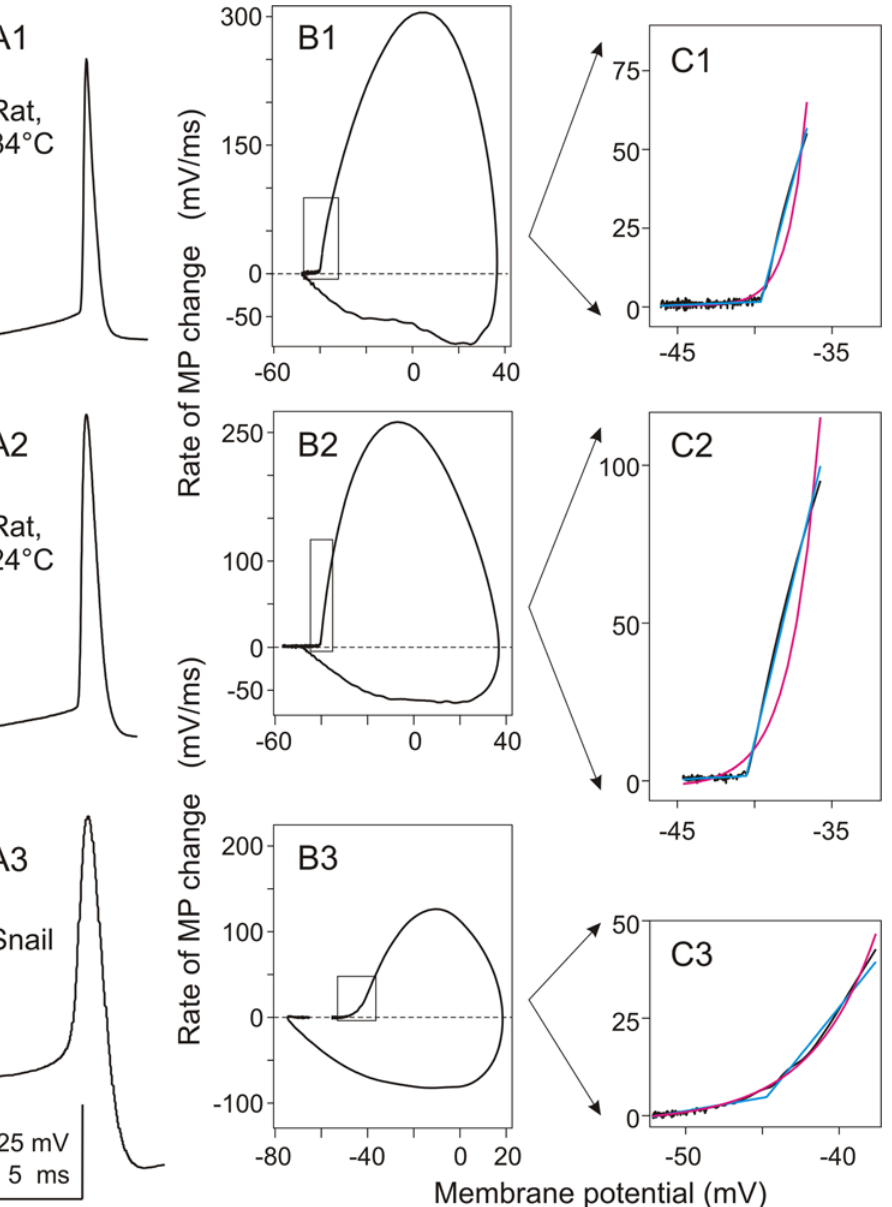
Figure 1. Action potentials recorded in neurons in rat neocortex (A1–C1 and A2–C2) and in snail neuron (A3–C3) have different onset dynamics. A: Waveform of the action potentials recorded in two rat neocortical neurons at 34 u C (A1) or 24 u C (A2) and in a small cerebral neuron (20 m m soma diameter) in snail (A3). B: Phase plot representation of the APs from A. C: Close-up of the initial portion of the phase plots indicated with boxes in B. Magenta lines show exponential fits, Cyan lines piecewise linear fits to the data. Ratio of errors of exponential fit over the piecewise-linear fit were 8.22 in C1, 12.3 in C2 and 0.55 in C3. Note different onset dynamics of the APs: rapid, step-like in rat neurons, but slow, exponential-like in the snail neuron. coincides with the data almost completely (cyan and black lines in Fig. 1 C1 and C2), while exponential function essentially fails to describe the AP onset dynamics in rat neocortical neuron (magenta line in Fig. 1 C1 and C2). Fitting the onset of a snail neuron AP gives a very different picture (Figure 1, C3). For the snail AP, an exponential function provides a very precise fit to the data (magenta and black lines in Fig. 1, C3), but the fit with a piecewise linear function is of inferior quality (cyan in Fig. 1 C3).